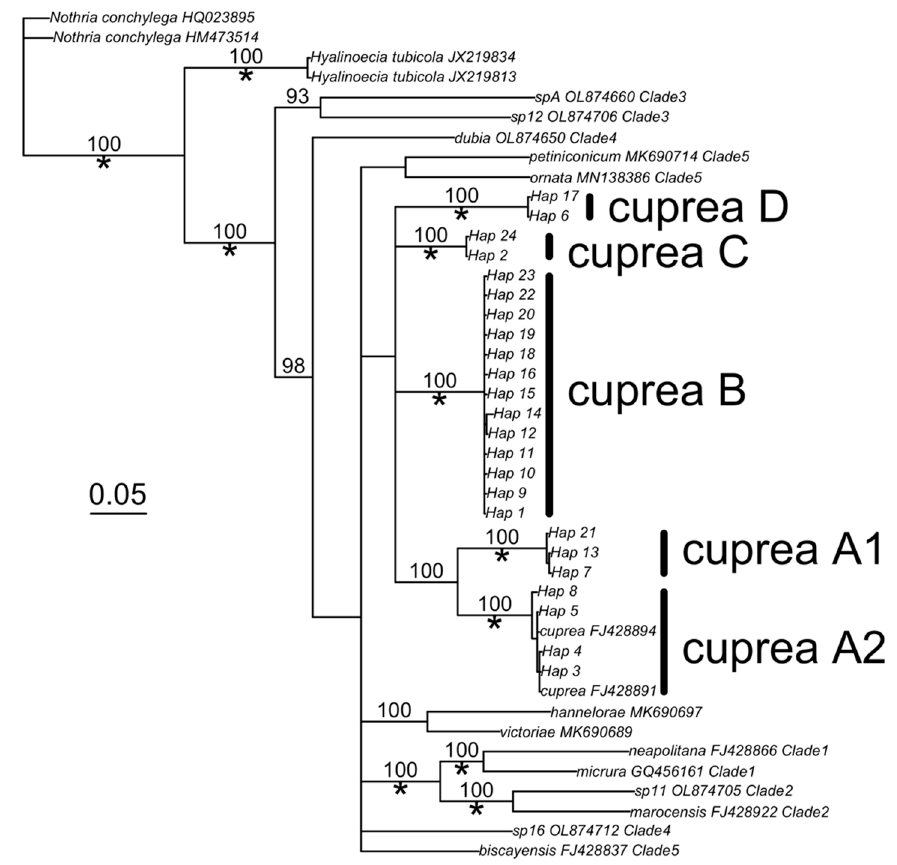
Figure 1. Cryptic Diopatra cuprea genetic diversity. The Bayesian phylogeny was based on 550 bp of cytochrome c oxidase I. Numbers on edges indicate posterior probability, while asterisks indicate 90% or greater maximum likelihood bootstrap support (100 replicates). Clade designations (i.e., numbers after taxa) were defined using the work of [12]. An approximate 5% divergence between haplotypes is indicated by the segment.